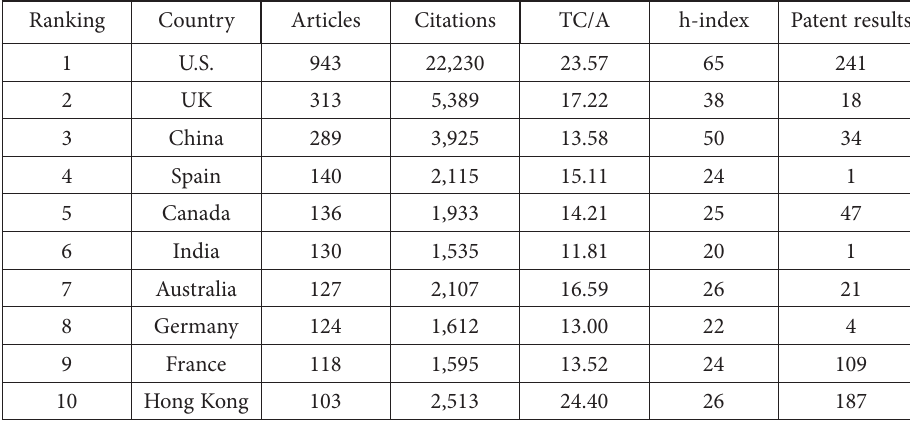
Table 1. Ranking of leading